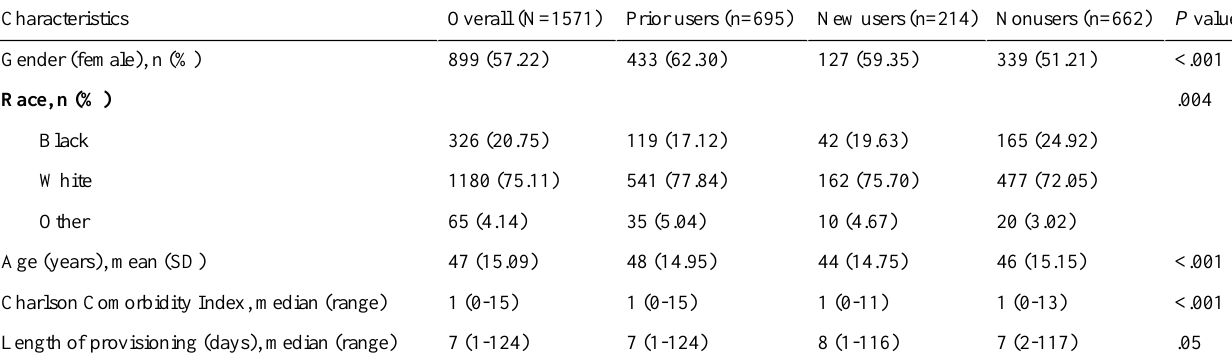
Table 1. Baseline characteristics of the study population by MyChart user